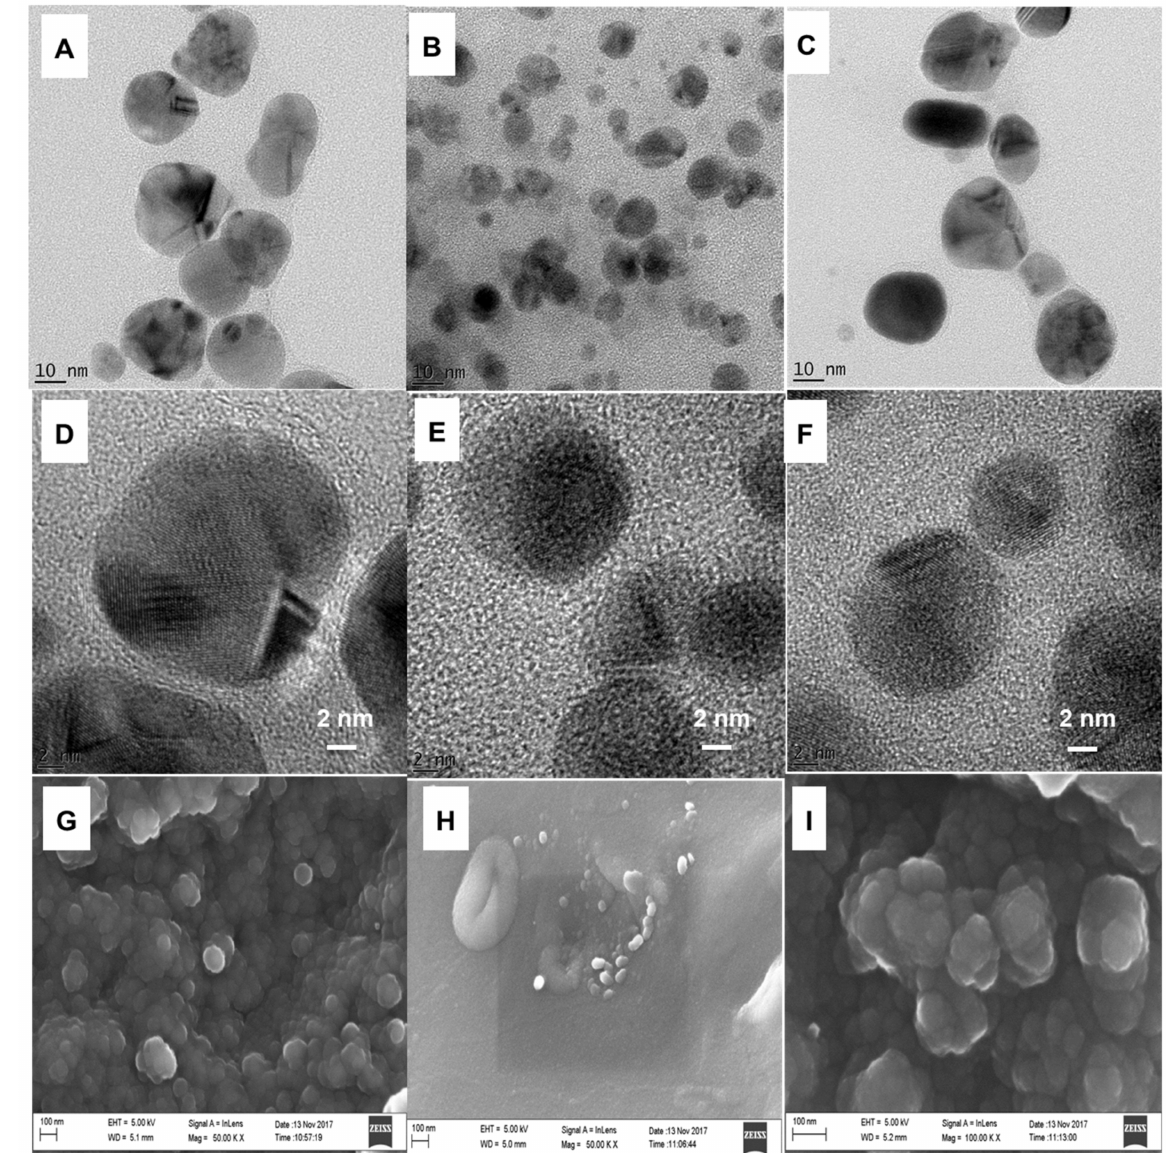
Figure 4. HRTEM images of ( A – C ) AgNPs, ZnONPs, and Ag–ZnONPs at 10 nm scale view, ( D – F ) at 2 nm scale view. HRSEM images of ( G – I ) AgNPs, ZnONPs, and Ag–ZnONPs at 100 nm scale